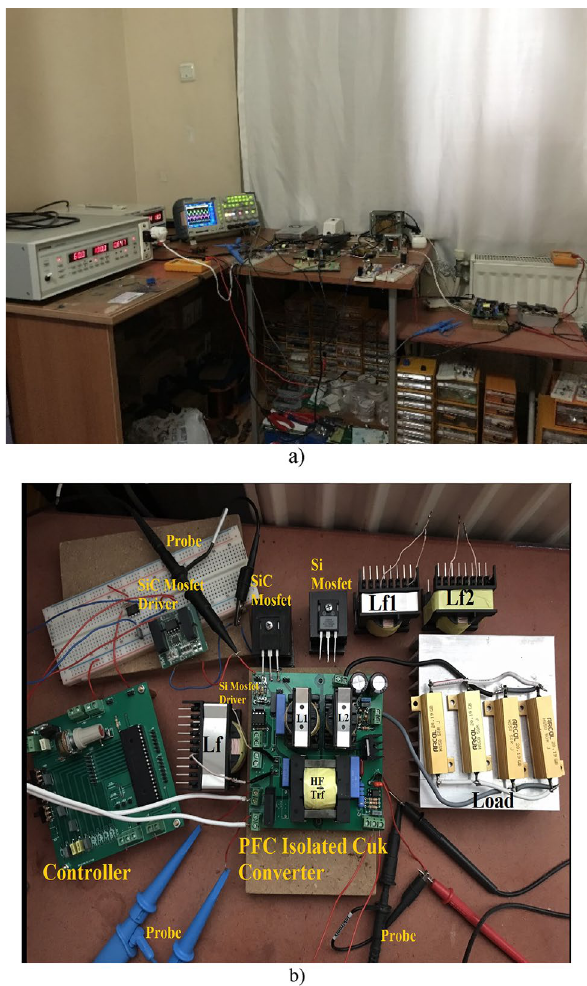
Figure 7. ( a ) Laboratory environment, ( b ) application circuit.